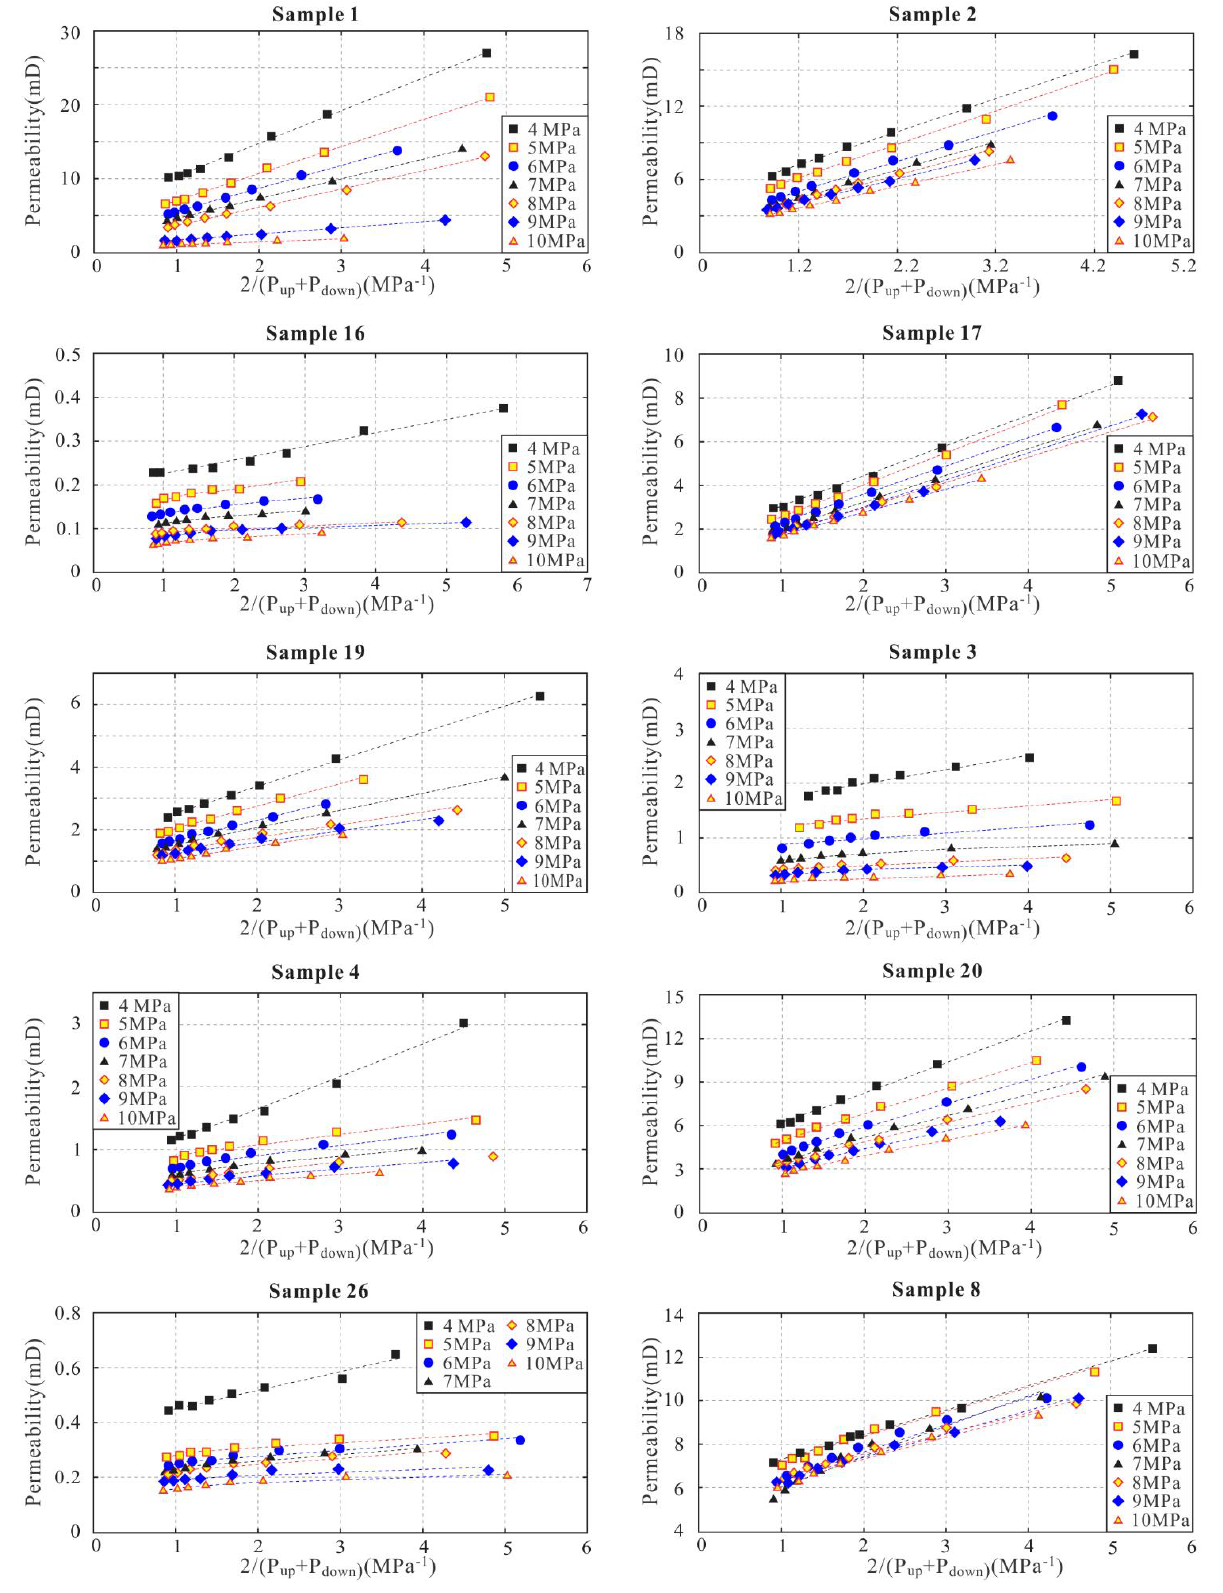
Figure 4. Gas permeability as a function of the inverse mean pore pressure (1/ P av ) at different con- fining pressures. The linear fits parameterize Equation (2), yielding the apparent liquid (Klinkenberg) permeability k and the Klinkenberg slip factor b .